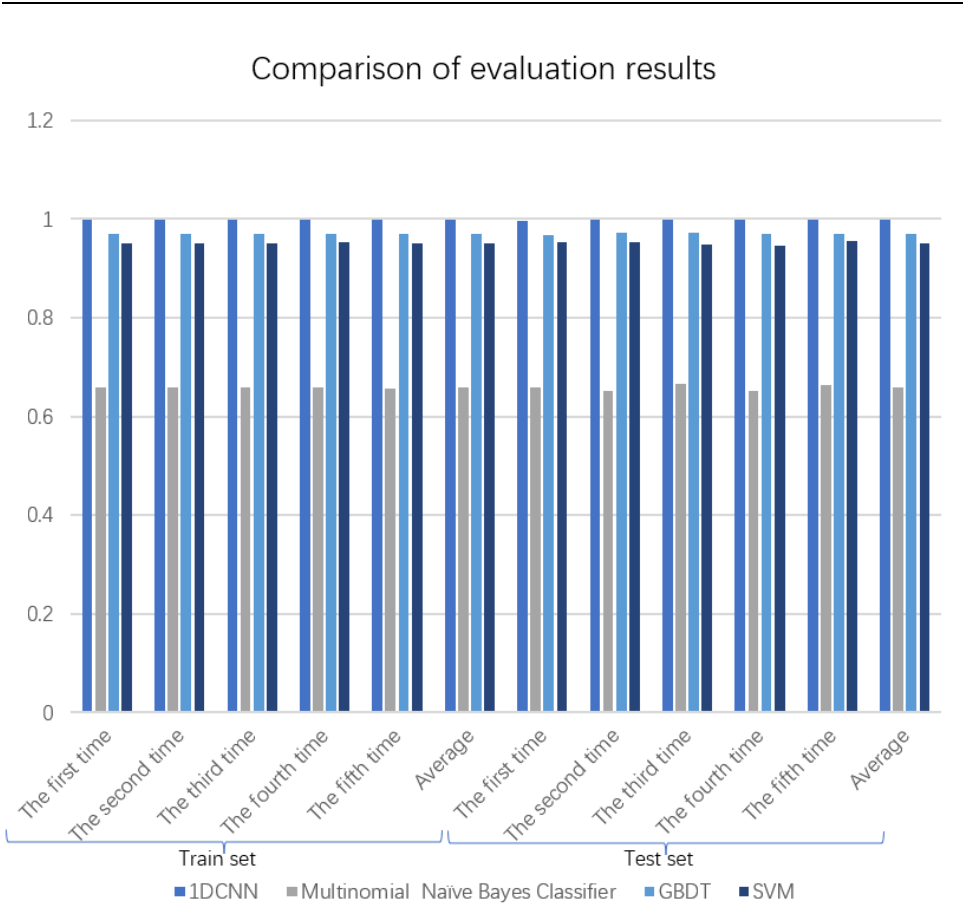
Figure 10. Comparison of evaluation